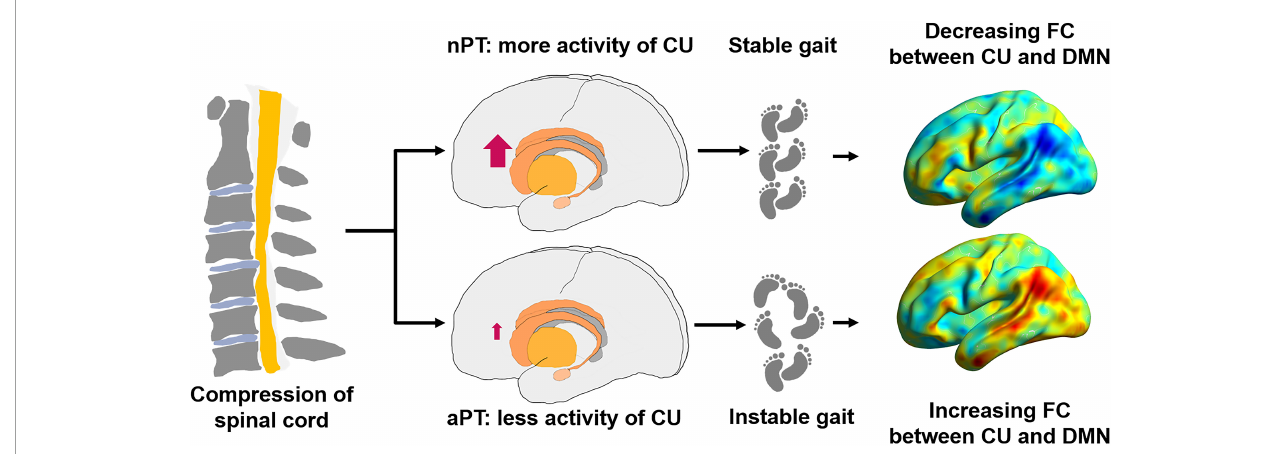
FIGURE5 Possible pattern diagram of relationship between the caudate nucleus, the DMN and gait impairment. nPT, normal gait patients; aPT, abnormal gait patients; CU, caudate nucleus; FC, functional connectivity; DMN, default mode